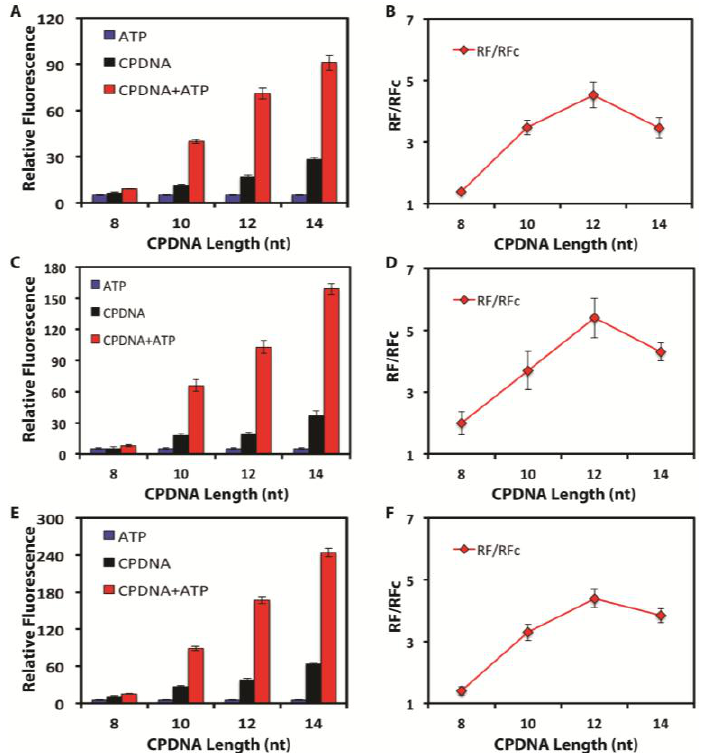
Figure 3. Optimization of the complementary DNA (CPDNA) length (nucleotides, nt) and concentration. FAM-labeled DNA biosensor-GO was incubated for 1 h, then target ATP (blue, 500 μM), CPDNA (black), or a combination of CPDNA + target (red) was added. Relative Fluorescence (RF) was plotted after 1 h. RF = F T − F B , where F T is the fluorescence reading of a test mixture; F B is the fluorescence reading of the blank mixture. ( A ) CPDNA: 10 nM; ( B ) RF/RFc vs. CPDNA length, where RF is the red plot in ( A ) and RFc is the blank plot in ( A ); ( C ) CPDNA: 100 nM; ( D ) RF/RFc vs. CPDNA length, where RF is the red plot in ( C ) and RFc is the blank plot in ( C ); ( E ) CPDNA: 1000 nM; and ( F ) RF/RFc vs. CPDNA length, where RF is the red plot in ( E ) and RFc is the blank plot in ( E ). The data are an average of three independent